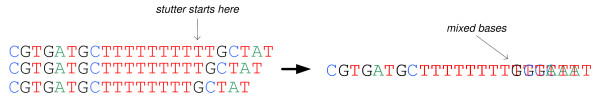
Trace phase shifting events occur when a PCR reaction creates a mixed population of DNA molecules that are then simultaneously sequenced.